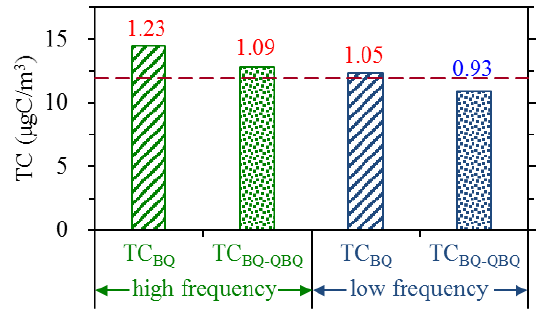
Figure 2. Comparison of the 48h averaged TC concentrations mea- sured by different sampling configurations and frequencies. The dashed line corresponds to the reference value, which is the aver- age of the TC concentrations measured by the high-frequency de- nuded filters (i.e., DQ). The bars indicate the alternative TC estima- tions. The values above each bar are the average of the alternative- to-reference ratios, while the red and blue fonts indicate an overes- timation and underestimation,